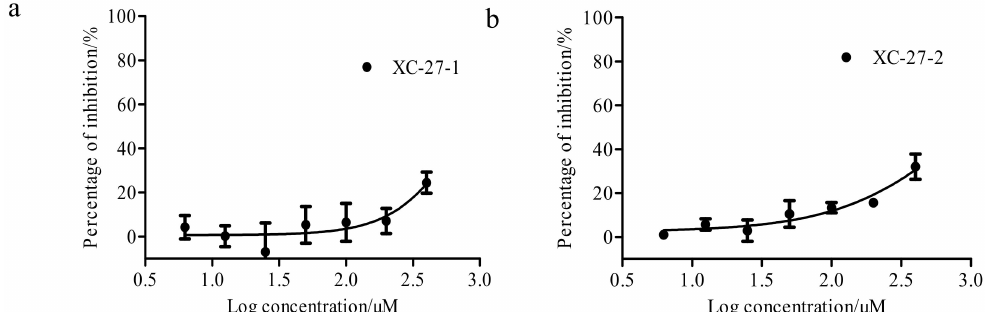
Figure 4. Dose–response curves of the derivatives inhibiting the neuraminidase activity of H5N1 pseudovirus. ( a , b ) represent the dose-response inhibition curves of XC-27-1, XC-27-2 to NA, respectively. The error bars represent mean ± standard deviation (three replicates). The horizontal axis represents the log concentration of the derivative, and the vertical axis represents the inhibition